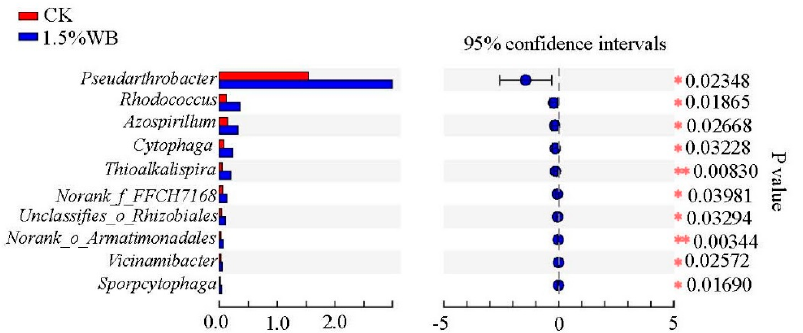
Figure 4. Extended error bar plot showing the ten most abundant genera with significant differences between different treatments in coastal soils without and with WB addition at the rate of 1.5%. CK: soil treatment without WB amendment; 1.5% WB: soil amended with WB at the rate of 1.5% ( w / w ). Statistically significant differences among the relative bacterial abundance at genus level in the dif ‐ ferent soils were performed by metastats analysis.